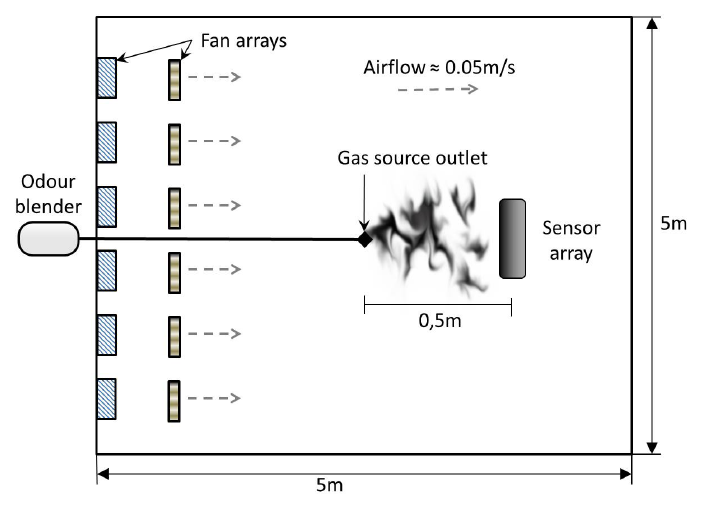
Figure 2. Schematics of the experimental